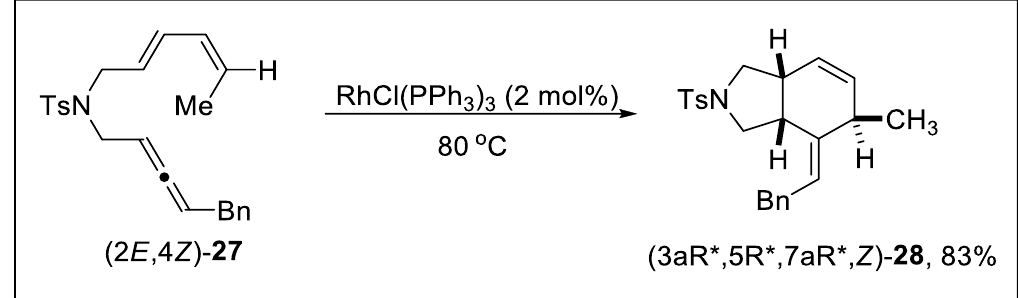
Scheme 8. Rh(Ι) -catalyzed formation of cis -6,5-fused bicycle 28 .